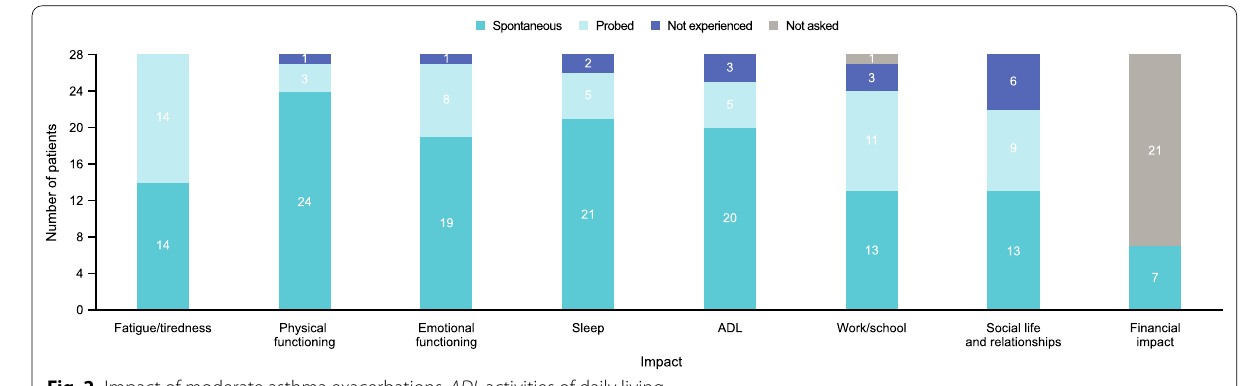
Fig. 2 Impact of moderate asthma exacerbations. ADL activities of daily living